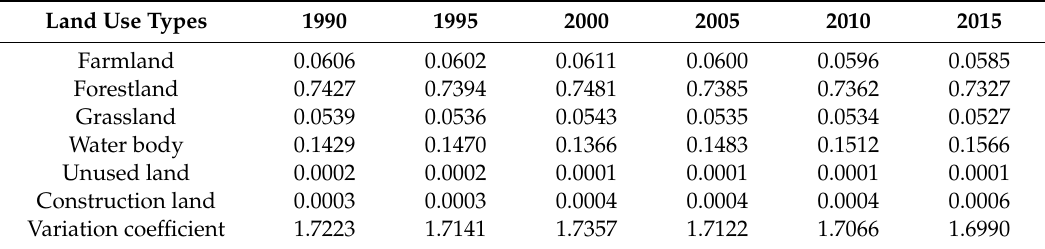
Table 3. Coe ffi cient of sensitivity and variation for ecosystem service